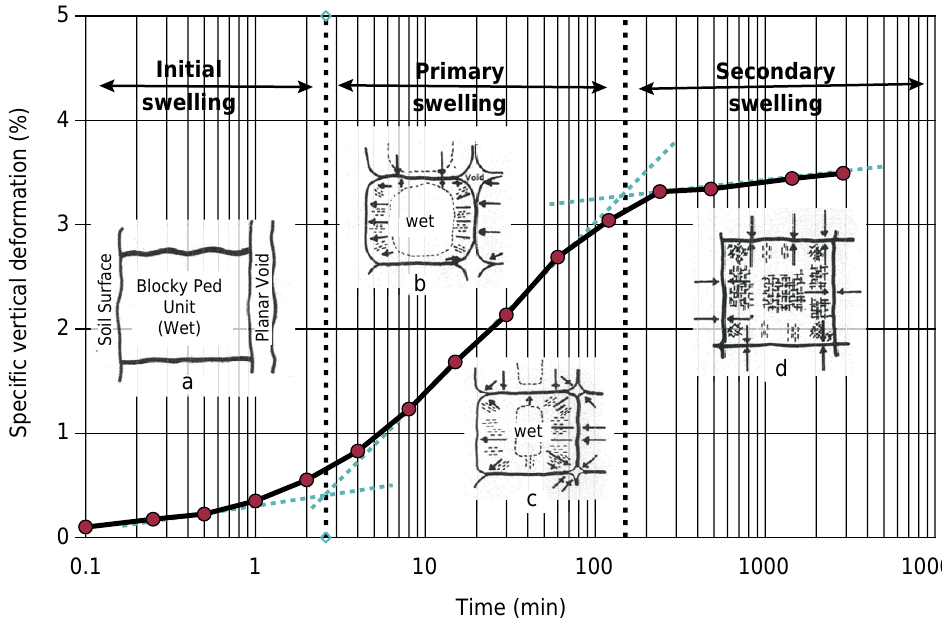
Figure 10. Soil behavior during